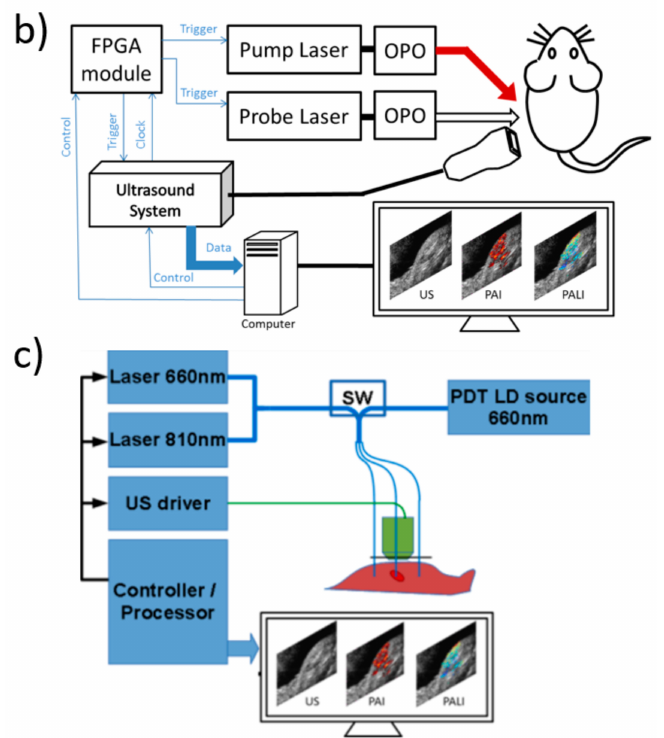
Figure 4. ( a ) Photoacoustic lifetime imaging for hypoxia detection (reproduced with permission from [42]); ( b ) Schematic of in vivo multimodal imaging system, which is capable of generating US (ultrasound), PAI, and PALI images using the same hardware (reproduced with permission from [45]. Copyright SPIE, 2013); ( c ) A combined PDT/PALI therapy/imaging system. A common fiber-optic bundle is used to deliver light into the tissue. A 660 nm emitting laser-diode is used for PDT. Open development platform is used for ultrasound multi-channel data acquisition. A 64-element US linear array is used for US, PAI, and PALI imaging operation. A FPGA (field programmable gate array) module is used to synchronized laser firing and signal acquisition. A PC is used as a system controller, data processing, and display (reproduced with permission from [47]. Copyright SPIE,